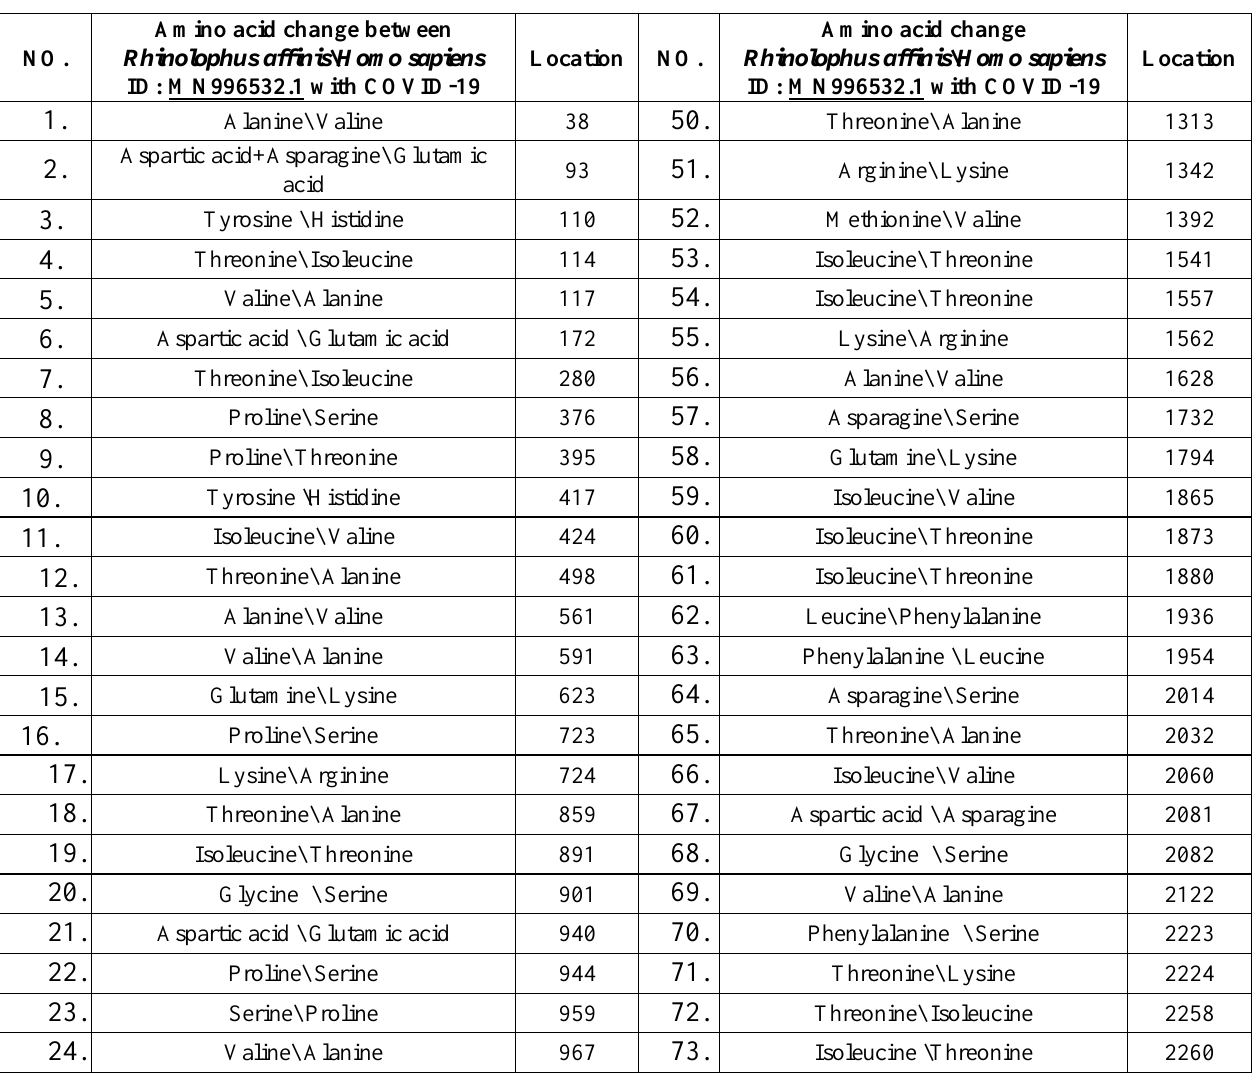
Table 3. Represent type of Amino acid polymorphism of Coronavirus isolate between Rhinolophus affinis and Homo sapiens (the Predicted effect is